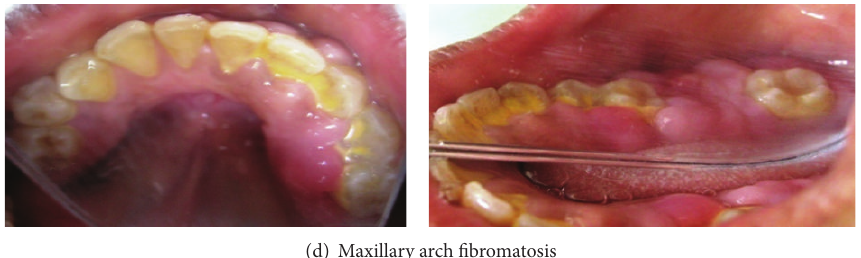
Figure 2: Preoperative intraoral picture of generalized gingival